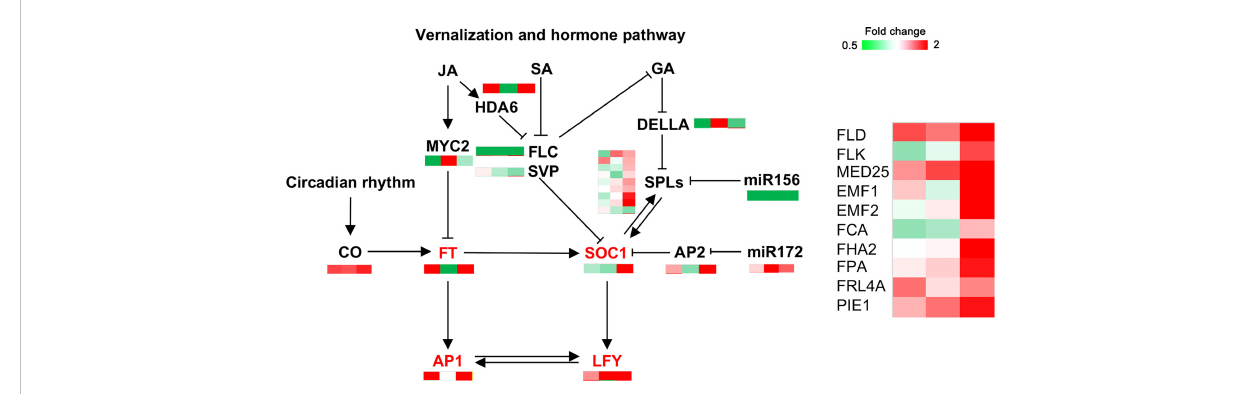
FIGURE 8 DEPs related to fl ower bud formation in Camellia oleifera . (The pattern near each gene was representative of the ratio of their expression levels between MY3 and QY2. Left: MY3/QY2 at 4.14, MY3/QY2 at 4.21, right: MY3/QY2 at 4.30).